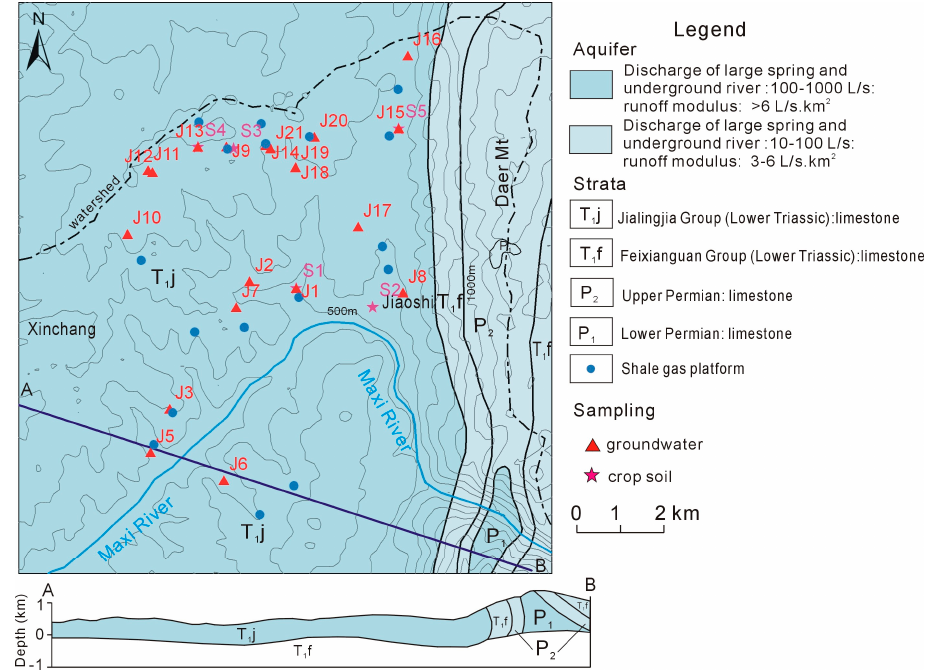
Figure 2. Hydrogeological conditions and shallow groundwater and soil sampling location in the JSB area.